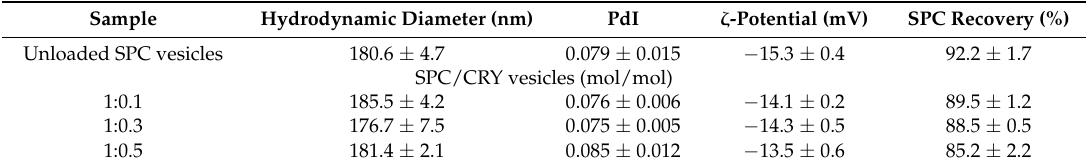
Table 1. Physicochemical features of soybean phosphatidylcholine (SPC) unilamellar vesicles (ULV) liposomes.